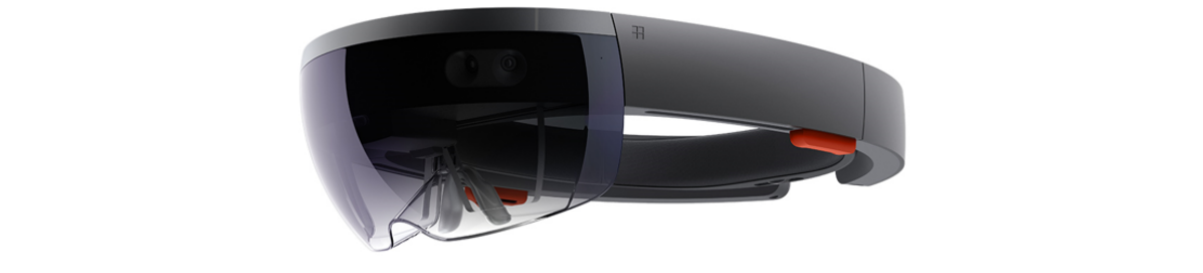
Figure 2. Microsoft HoloLens, a head-mounted augmented reality device to display 3D virtual